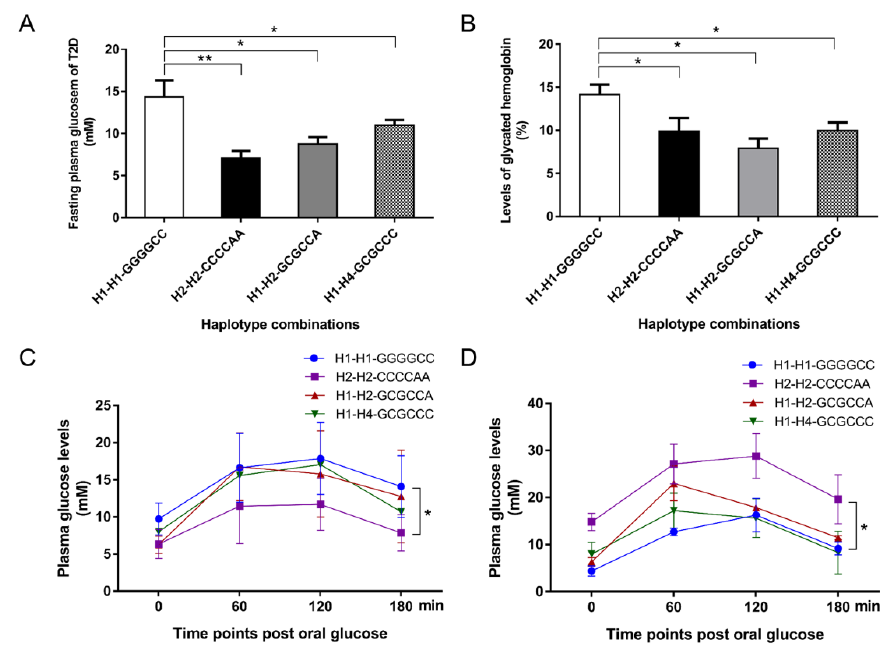
Figure 3. Associations of the SIRT2 haplotype combinations with clinical characteristics in T2D patients. E ff ect of haplotype combinations on fasting plasma glucose ( A ) and glycated hemoglobin levels ( B ). E ff ect of haplotype combinations on glucose content ( C ) and insulin level ( D ) during an OGTT test. Data are given as the mean ± SE. * p < 0.05 or ** p < 0.01 shows a significant di ff